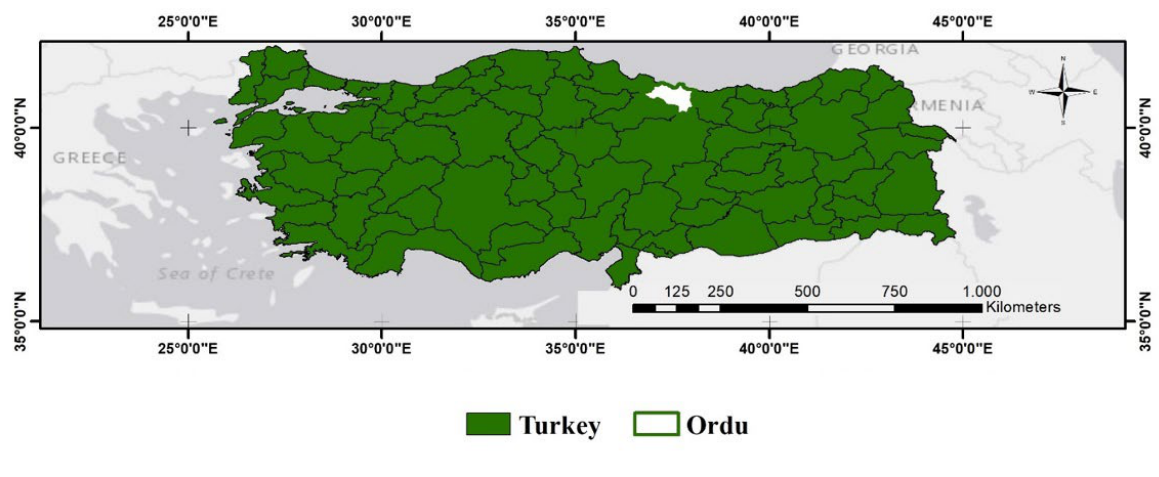
Figure 1 Ordu Location Map (Alrabiti